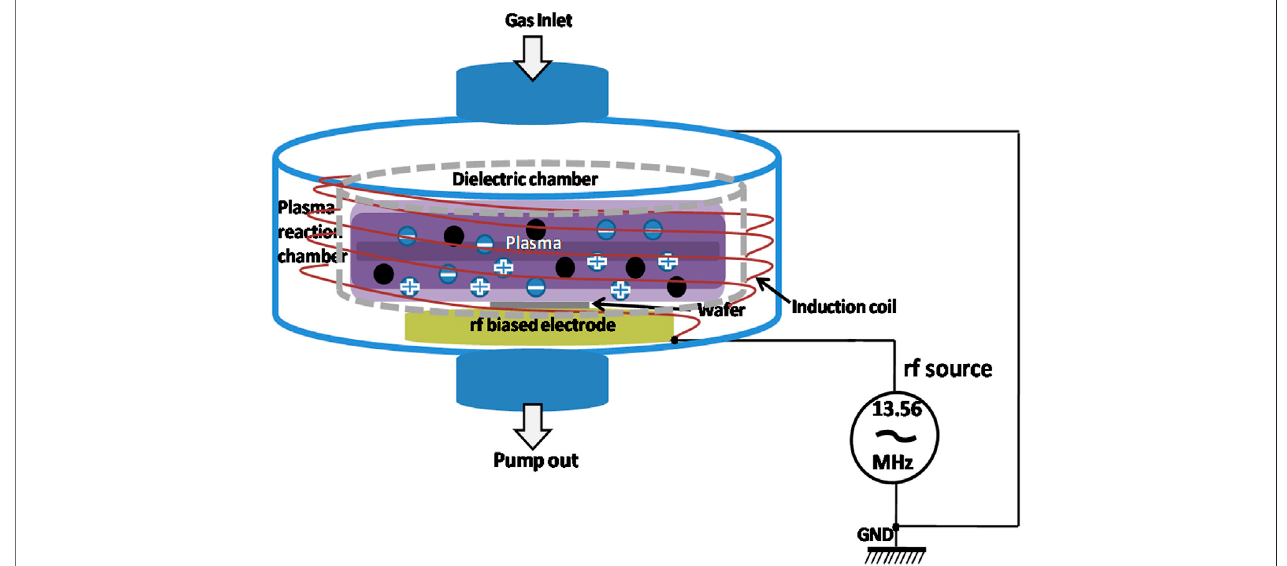
FIGURE 4 | Schematic con fi guration setup of Inductively Coupled Plasma.